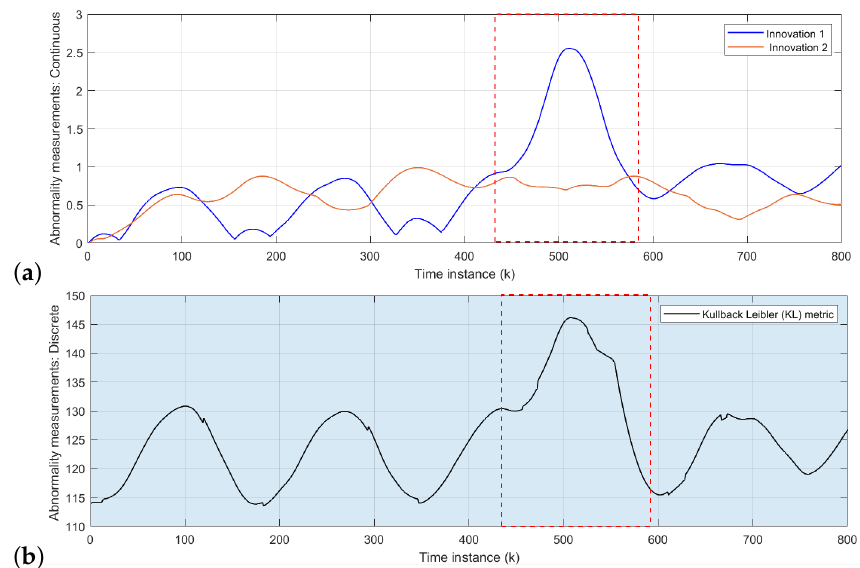
Figure 9. Abnormality measurements: Task 3 test data: ( a ) Continuous level anomaly: the blue and orange plots belong to the anomaly estimated for iCab1 and iCab2 , respectively. The blue plot’s highest peaks represent the situation where the iCab1 performed an emergency stop operation when it detected the presence of a pedestrian. ( b ) Discrete level abnormality: the peaks show the global anomaly detected by the